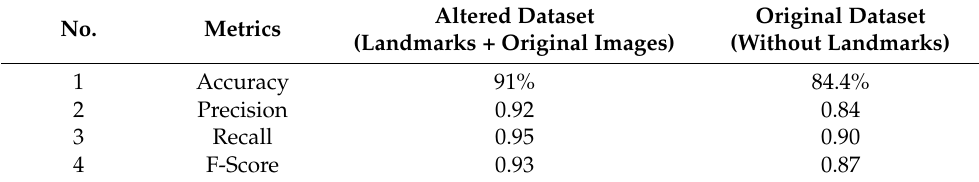
Table 5. Experimental results.